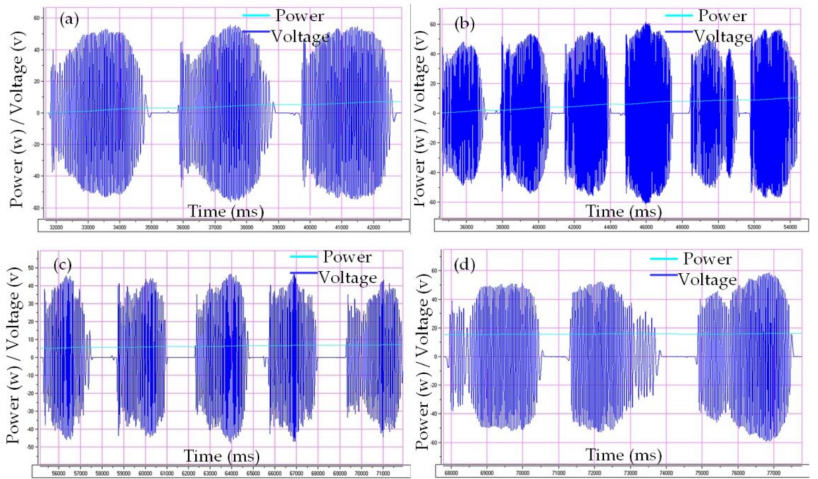
Figure 23. Effect of different input parameters on output power (the dark line is the voltage mea- surement value, the light line is the MPPT output): ( a ) . ϕ = 10,000 rpm, T = 7 s, A = 10 ◦ , P = 10.7 W; ( c ) ( b ) . ϕ = 10,000 rpm, T = 7 s, A = 12 ◦ , P = 13.8 ( d )